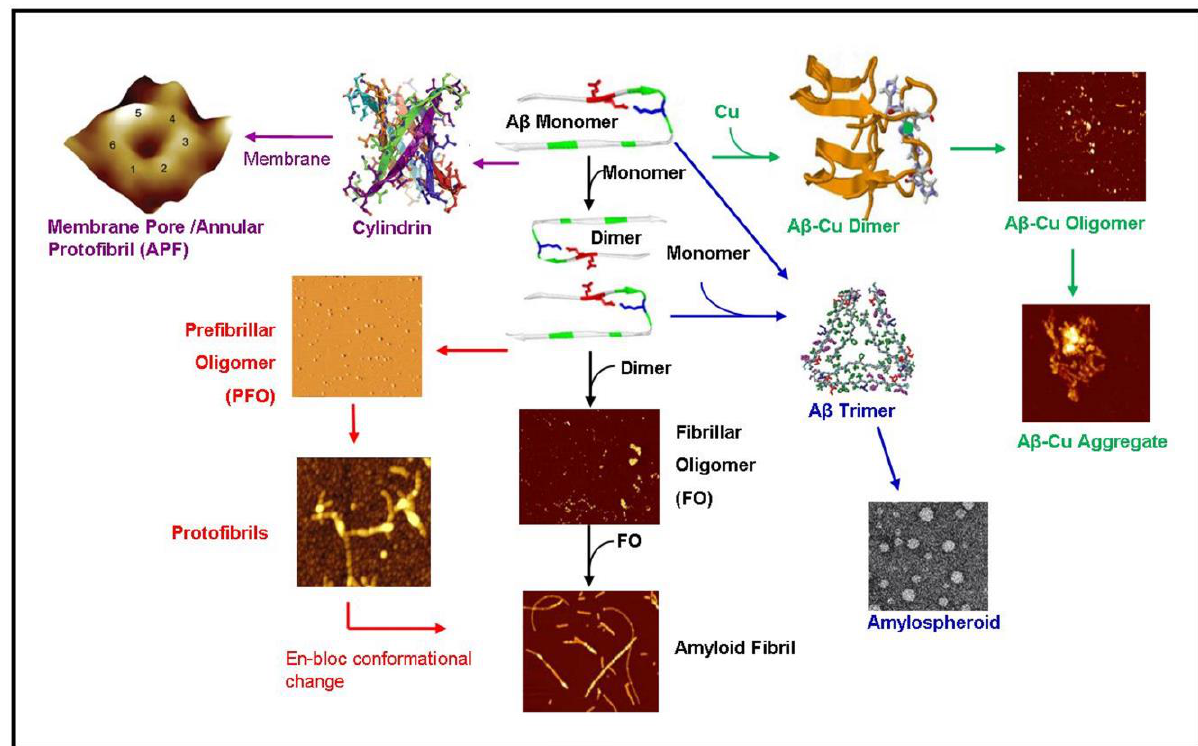
Figure 2. Diagram summarizing known amyloid-β aggregation pathways. The aggregation begins as an amyloid- β (Aβ) monomer which dimerizes eventually forming OC+ fibrillar oligomers (black pathway) [62]. The fibrillar oligomers polymerize to form mature amyloid fibrils [13]. Alternatively, the amyloid dimer can form A11+ prefibrillar oligomers (PFO) forming protofibrils (red pathway) [63,64]. These protofibrils may undergo an en-bloc conformational change to form amyloid fibrils [63]. The monomer may also travel along a pathway ending in amylospheriods (blue pathways) [4,65]. The pathways has a trimeric intermediate [66]. In the presence of copper (green pathway), amyloid dimerization is mediated by a copper ion forming small amyloid-copper oligomers [67] and eventually leading to larger amyloid-copper aggregates [13]. In the pathway mediated by lipid membranes (purple pathway), the amyloid dimer forms a hexameric ion pore [46] which may be identical to the annular protofibrils (APF) identified by the Glabe group [42] or the recent atomic structure of the amyloid oligomer [49]. These hexameric ion pores may stack to form deeper dodecameric structures [43]. This diagram was created using images from [4,13,40–43,49,62,63,66,67]. Images are reproduced with permission from the